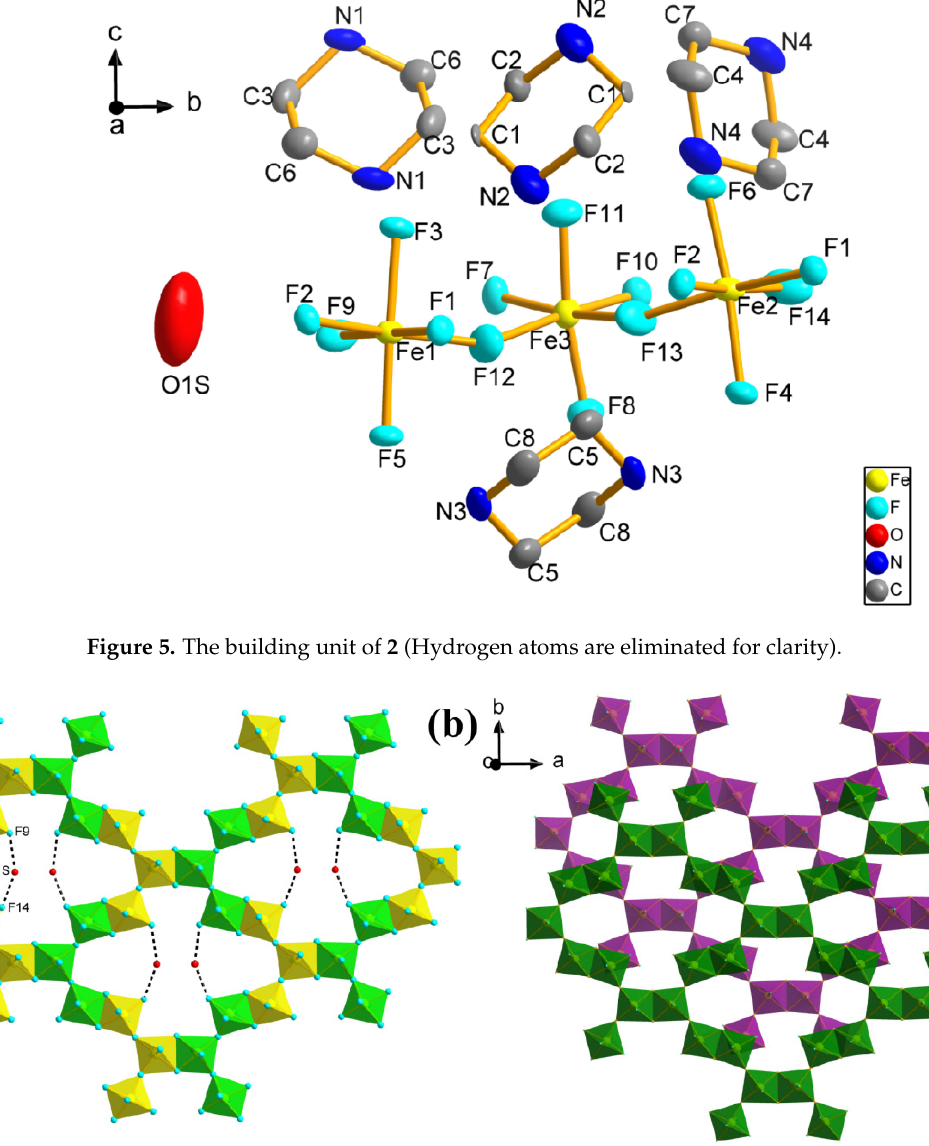
Figure 4. ( a ) The 2D layers with channel water molecules of 1 . The octahedra with different colours show how the “Y” shaped Fe-F building units are connected. (Hydrogen bonds are depicted by dotted lines); ( b ) Plan view of the layer stacking, with different layers shown in different colours. (H 2 pipz and water molecules are eliminated for clarity); ( c ) The stacking of the layers with H 2 pipz along the b -axis (Selected hydrogen atoms are eliminated for clarity but hydrogen bonds are de- picted by dotted lines).